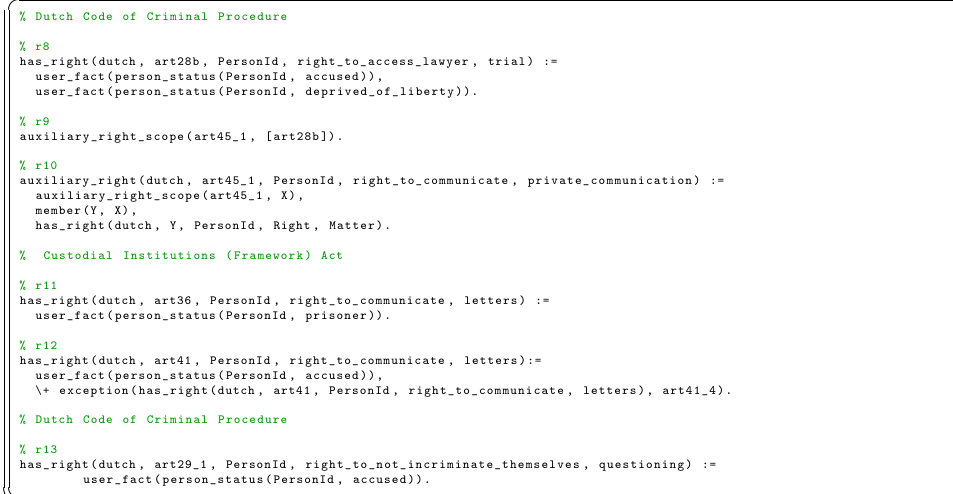
Figure 19. Facts in